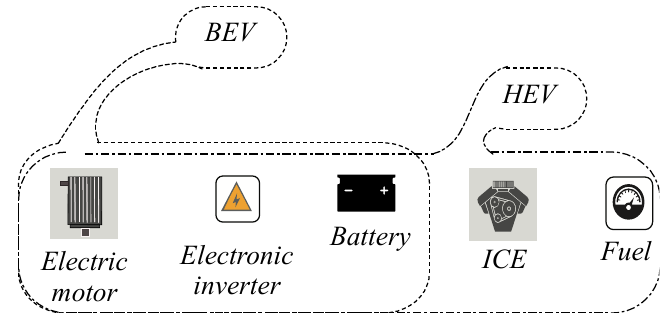
Figure 1. The architecture of the EV and the HEV.